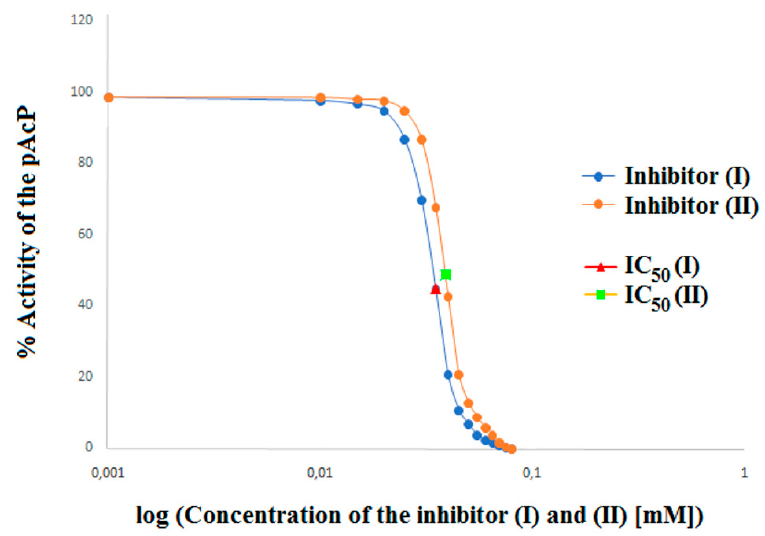
Figure 5. Determination of half-maximal inhibitory concentration (IC 50 ) for compound (I) and (II).